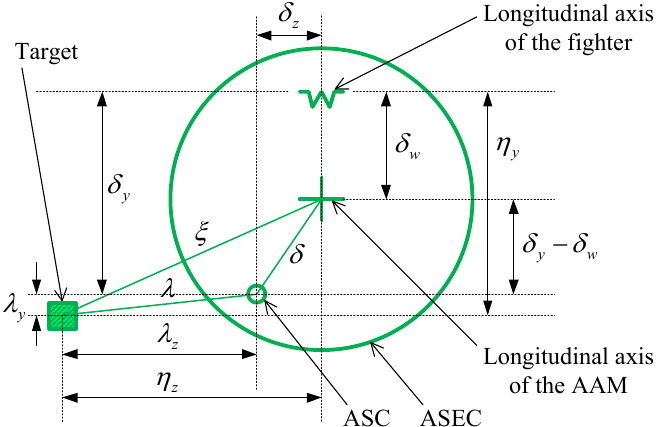
Figure 1. Simulated situation of the manned fighter’s HUD in the attack guidance state in the BVR air combat.